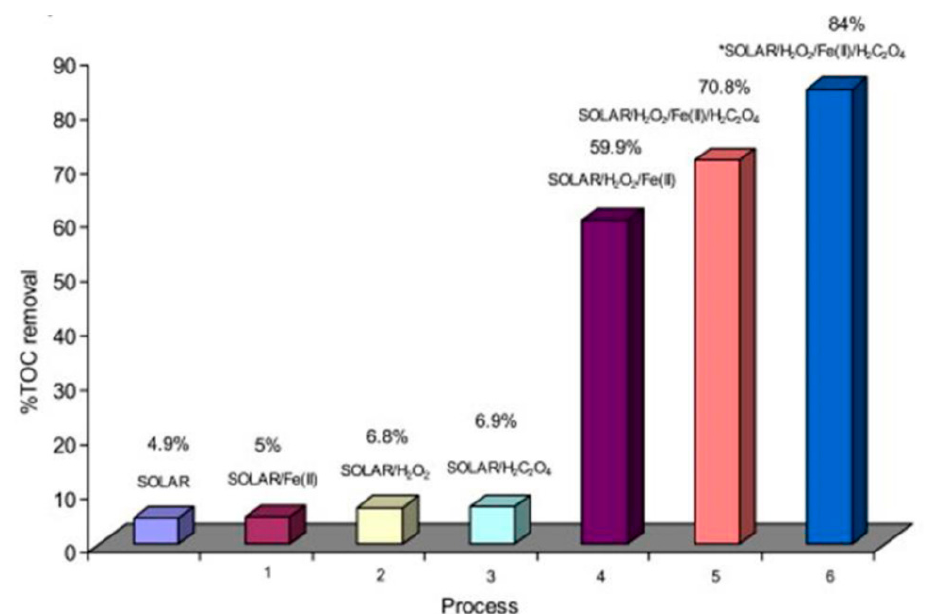
Figure 1. Mineralization of pharmaceutical wastewaters under several systems. (Reaction time: 115 min.; [TOC] 0 = 125 mg L − 1 ; Operating conditions: (1) [Fe(II)] 0 : 55 mg L − 1 ; (2) [H 2 O 2 ]: 5250 mg L − 1 ; (3) [H 2 C 2 O 4 ]: 325 mg L − 1 ; (4) [H 2 O 2 ]: 5250 mg L − 1 ; [Fe(II)] 0 : 55 mg L − 1 ; (5) [H 2 O 2 ]: 5250 mg L − 1 ; [Fe(II)] 0 : 55 mg L − 1 ; [H 2 C 2 O 4 ]: 325 mg L − 1 ; (6) [H 2 O 2 ]: 5250 mg L − 1 ; [Fe(II)] 0 :120 mg L − 1 ; [H 2 C 2 O 4 ]: 510 mg L − 1 ) (Reprinted from [18], with permission of Elsevier 2013).